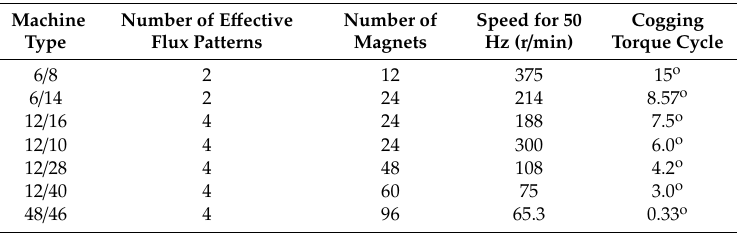
Table 3. Various possible configurations of PM FRM.